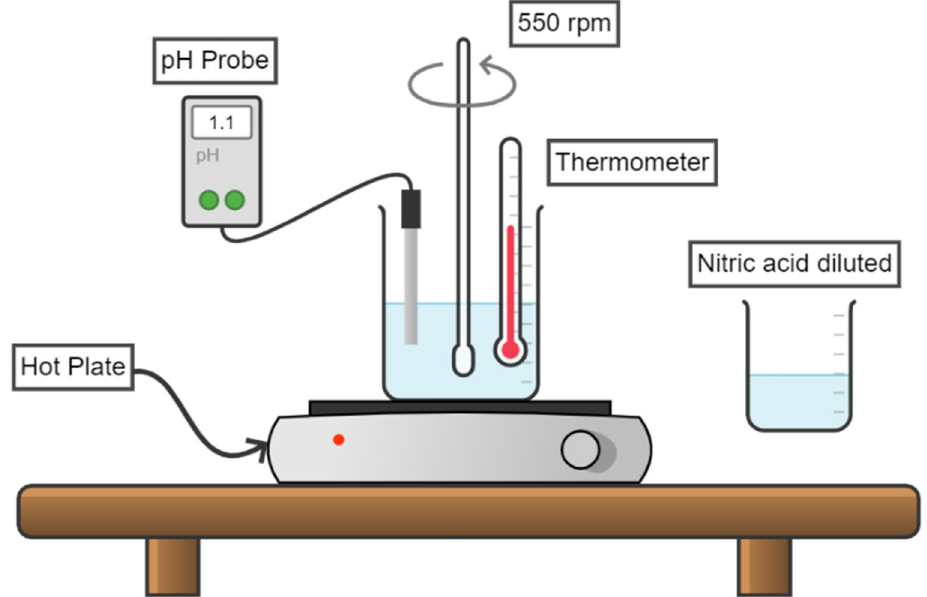
Figure 1. Experimental setup for synthesis of the potassium